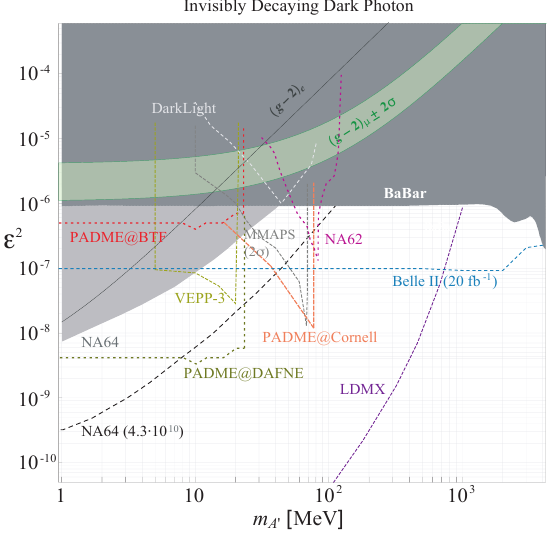
Figure 4. Sensitivity of various experiments to invisibly decaying Dark Photon. One should note that di ff erent experimental techniques are combined on the same